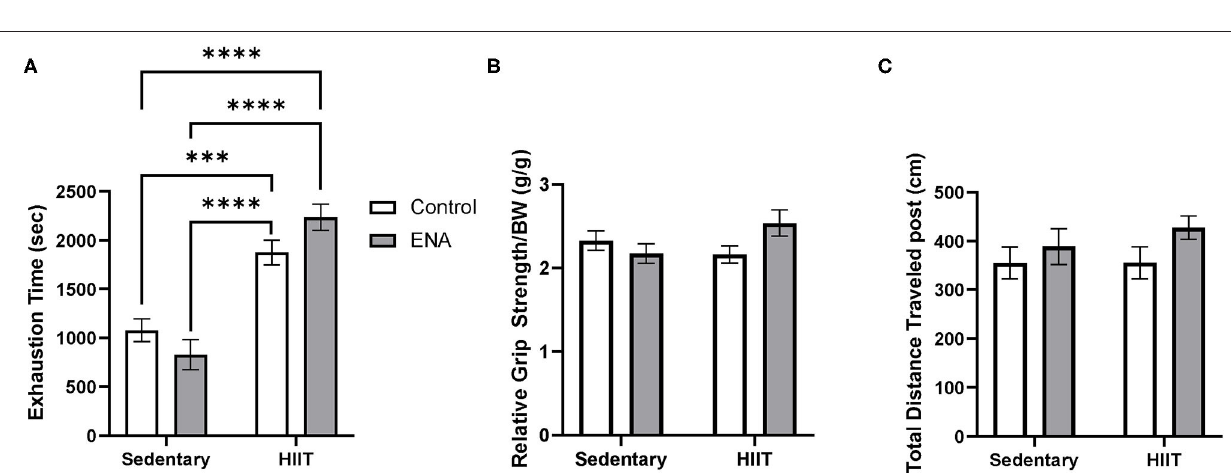
FIGURE 4 | Exercise tolerance, relative grip strength, and locomotive assay. (A ) Exercise tolerance after the intervention. (B) Grip strength by body weight after the intervention. (C) Total traveled distance in locomotor test. *** p < 0.001, **** p <